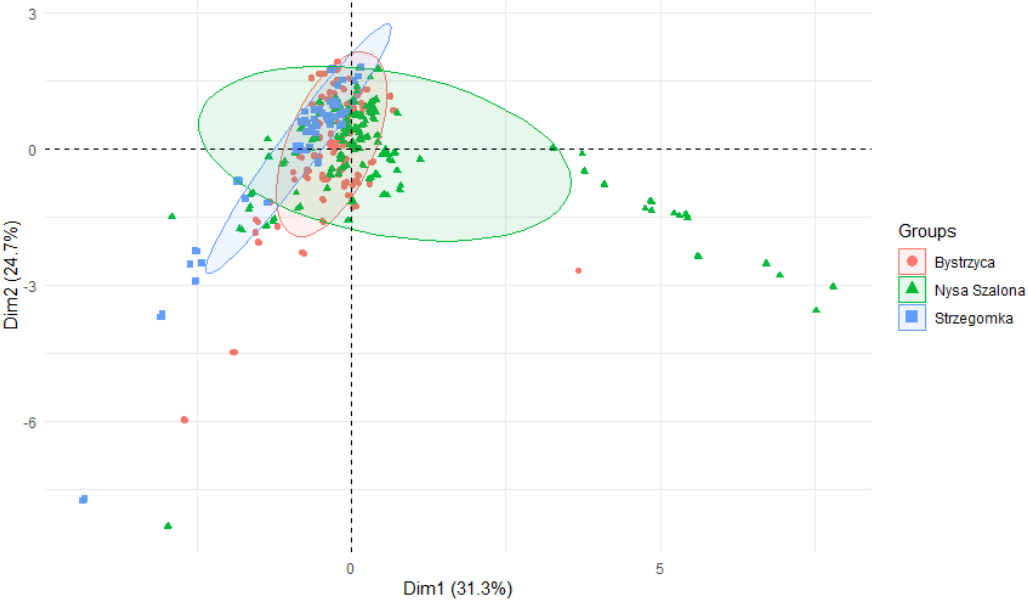
Figure 9. PCA plot 2D showing clustering of metals concentration in plants from rivers across 29 sites and 4 years (2015–2018) grouping factor—river.